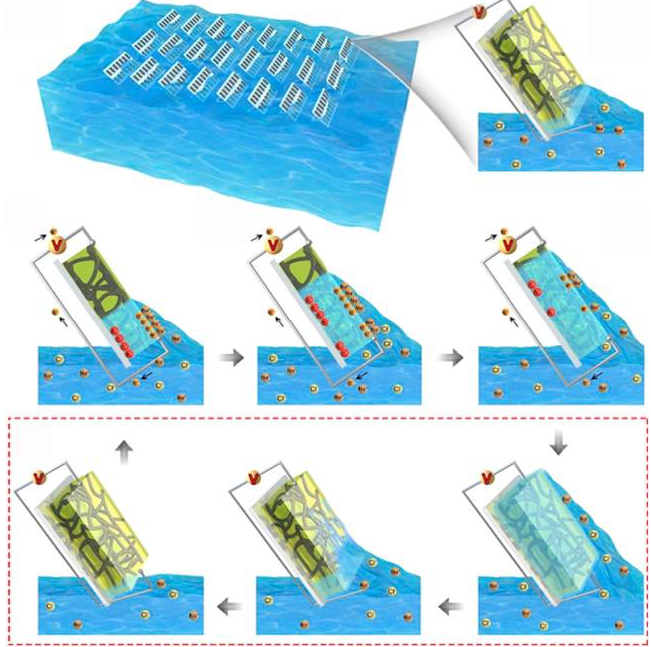
Figure 11. Membrane harvester network proposed (reproduced with permission [96]. Copyright 2018, Elsevier).